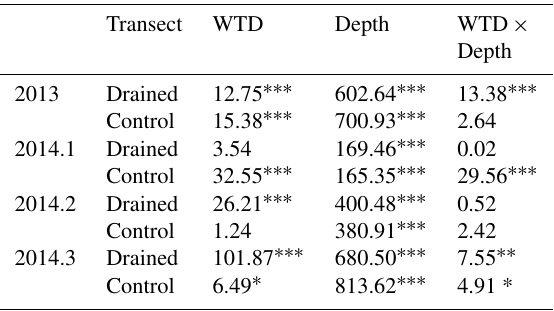
Table 3. ANCOVA results with WTD category (wet and dry), and soil depth (cm) as the independent variables and T soil ( ◦ C) as the de- pendent variable. The time periods of the entire year 2013, as well as three subseasons of 2014 – (2014.1) 15 June–5 July, (2014.2) 6–26 July, and (2014.3) 27 July–20 August – were separately ana- lyzed. The significance of F values are denoted with asterisks ( ∗∗∗ P < 0 . 001, ∗∗ P< 0 . 01, ∗ P< 0 .